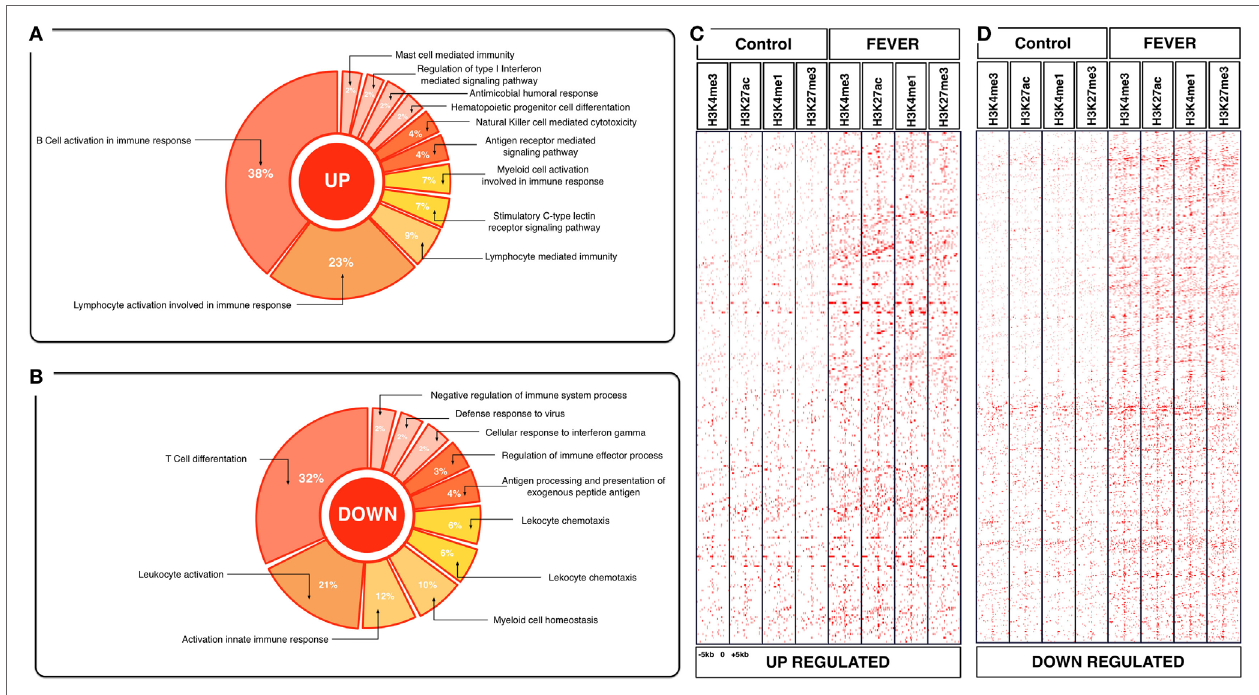
FigUre 4 | Effects of behavioral fever on the immunological process and histone landscape. Gene ontology enrichment analysis of transcripts involved in immune process in pronephros of fever individuals (GO DAVID and ClueGo Cytoscpae Plugin). (a) Upregulated genes and (B) downregulated genes. (c,D) Heat map showing chromatin immunoprecipitation-seq read density (log2 transformed) for the indicated of 1,726 WTR + / + genes referenced in salmon ENSEMBL database (down and up) at equivalent genomic regions in 5-kb windows upstream and downstream of the TSS binding sites (TSS; assumed to be at the 5 kp end of annotated genes). The specific genes were sorted into categories based on enrichment H3K4me1, H3K4me3, 3K27me3, and